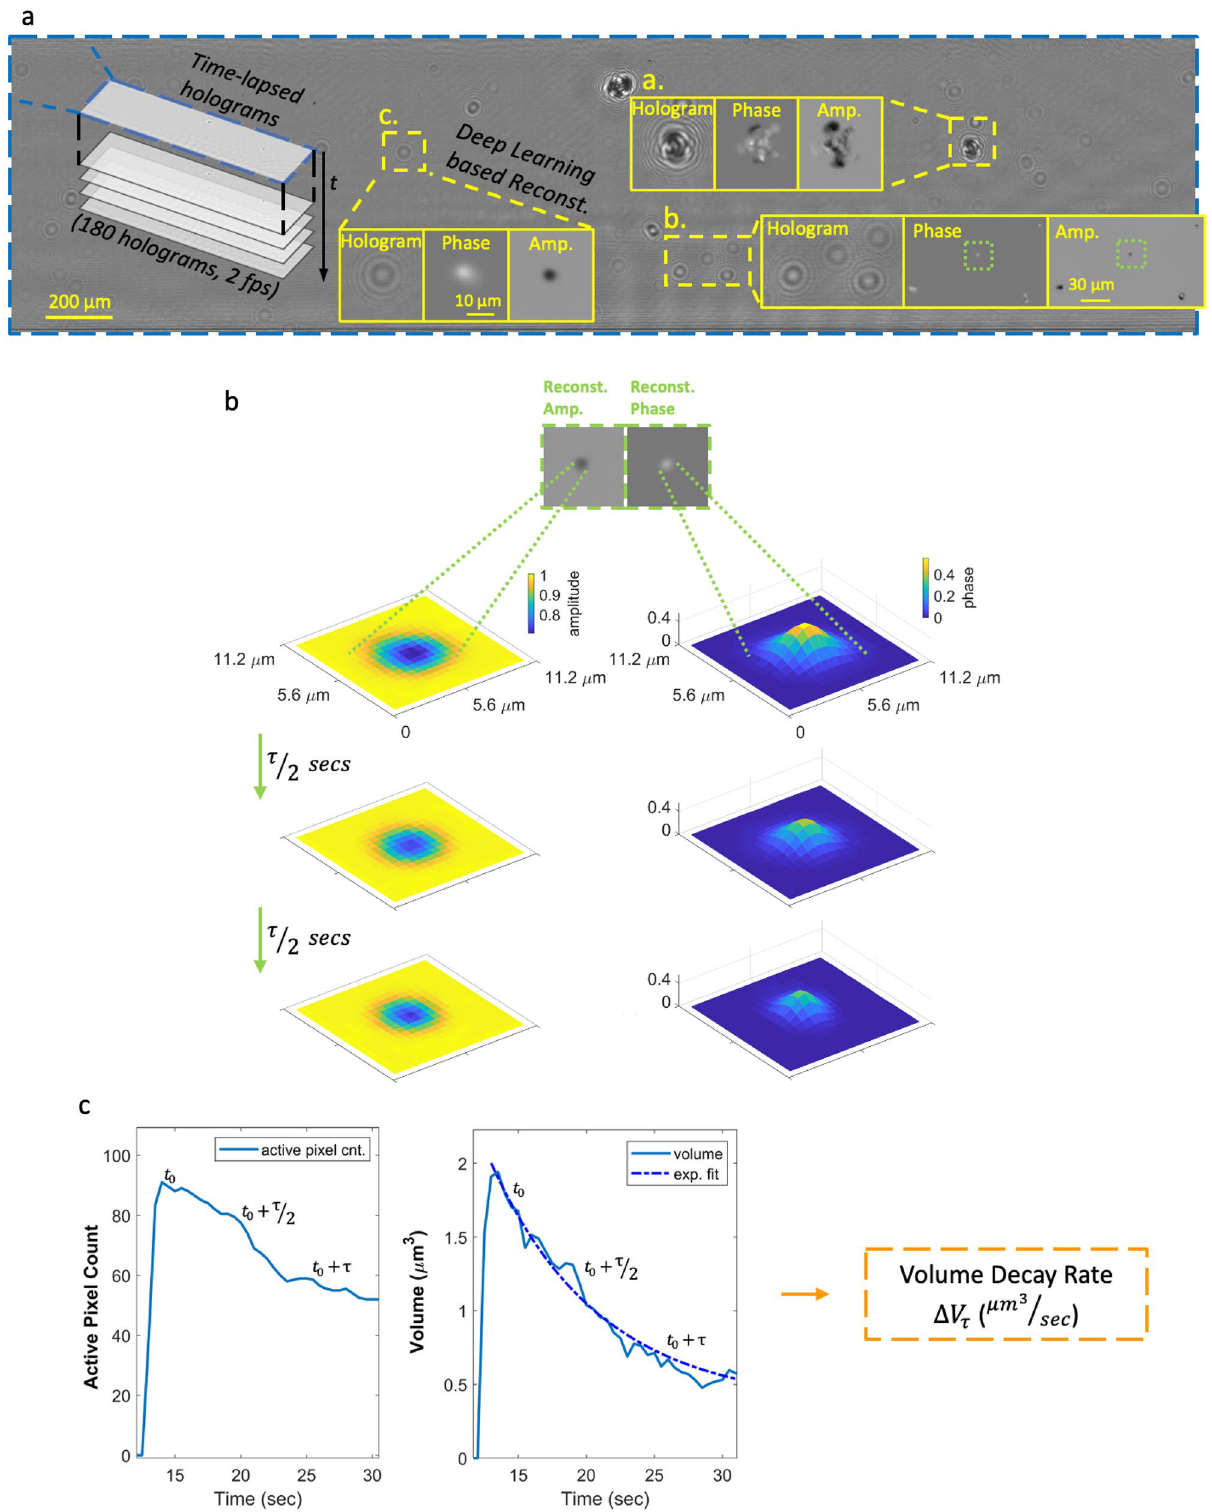
Figure 2. Calculation of the volatility of each detected aerosol: from raw holograms to volume decay rate. ( a ) A full field-of-view raw inline hologram and some example reconstructions showing the phase and amplitude channels separately. ( b ) An example aerosol image and the evolution of its holographic phase and amplitude channels at time points 0, τ/2 and τ, where τ is the exponential time constant (see Eq. (3)). ( c ) The plot of the active pixels in the amplitude channel as a function of time (left) and the exponential decay of the particle volume